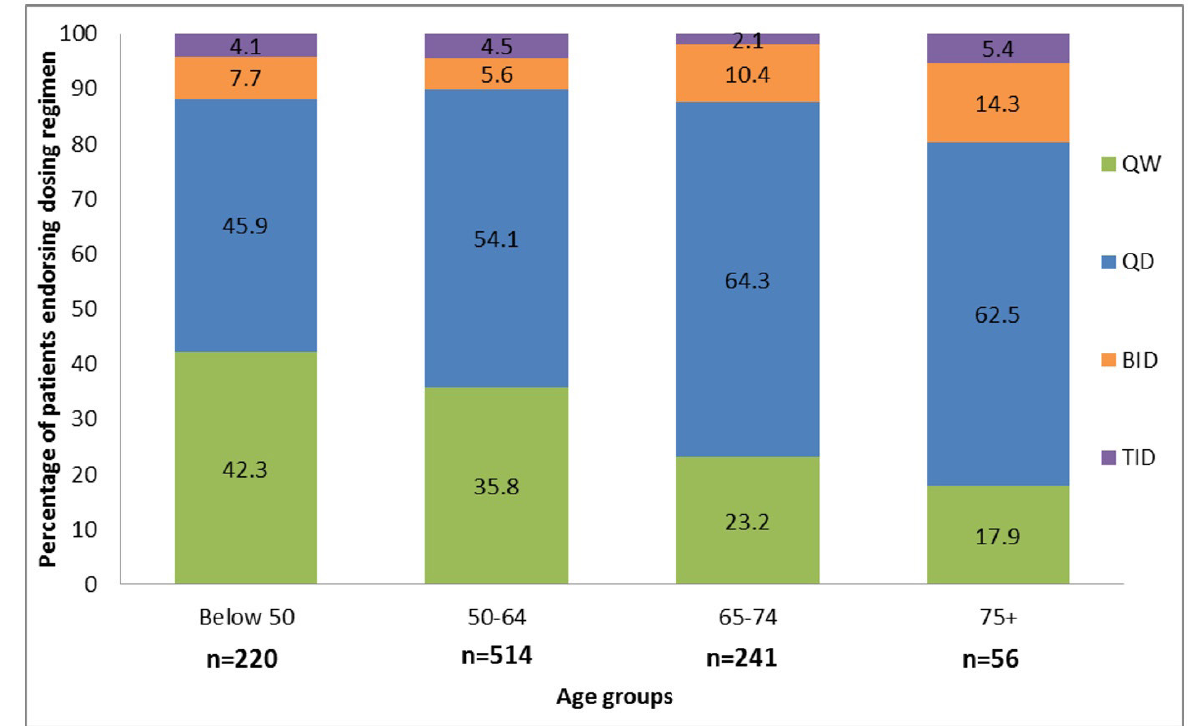
Figure 2. Frequency of Dosing Preference by Age Groups